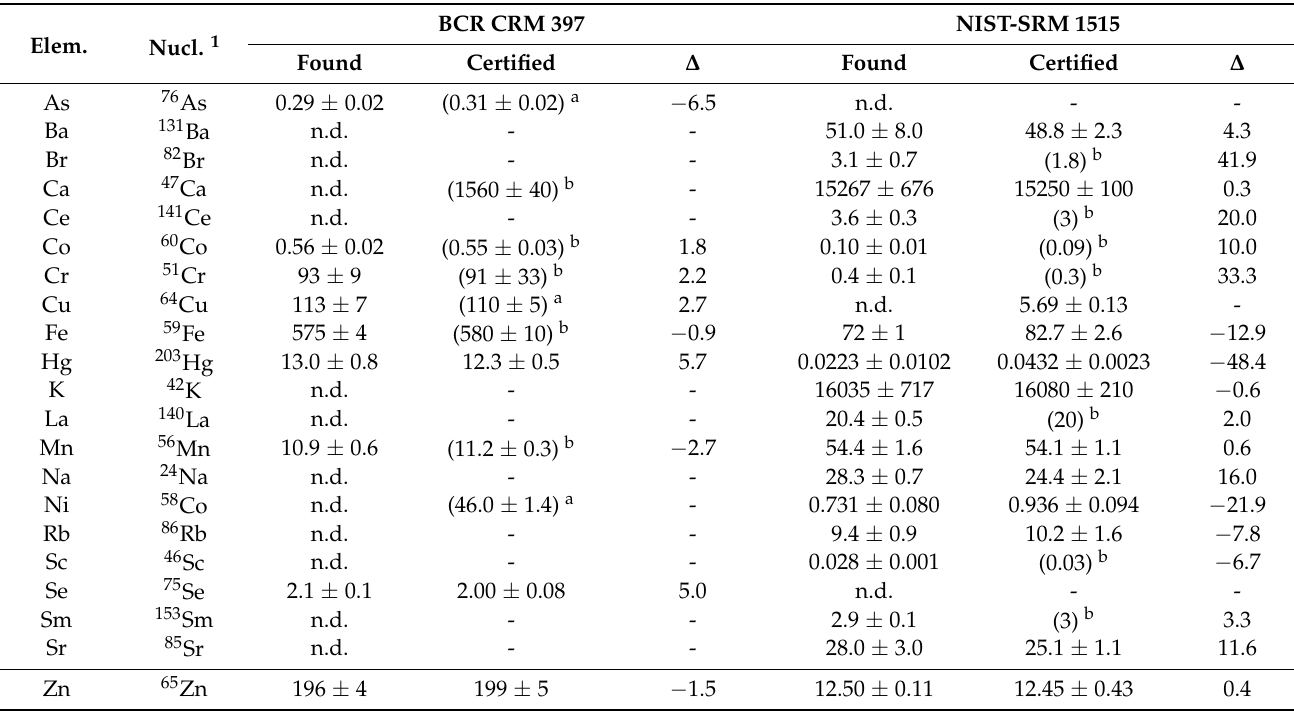
Table 1. Analytical standard comparison (mean ± s.d.; µ g g − 1 ) between our data and certified values: BCR CRM 397 (human hair) and NIST-SRM 1515 (Apple Leaves).